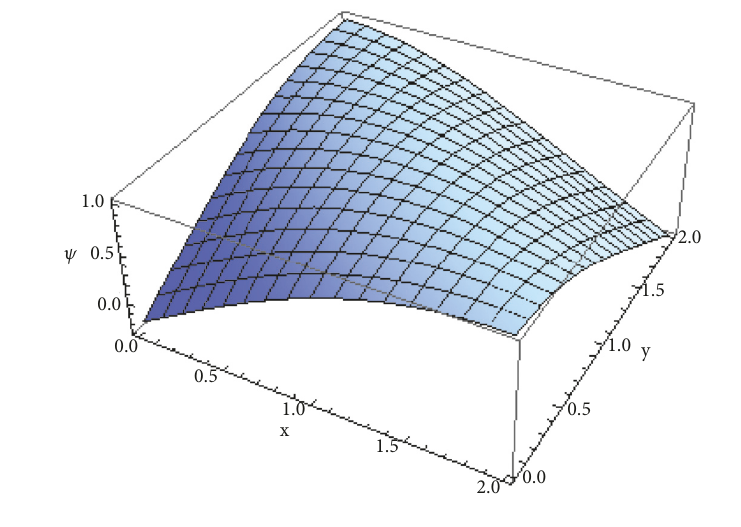
Figure 7: Imaginary solution of the two-dimensional wave function obtained by LADM and HPM.